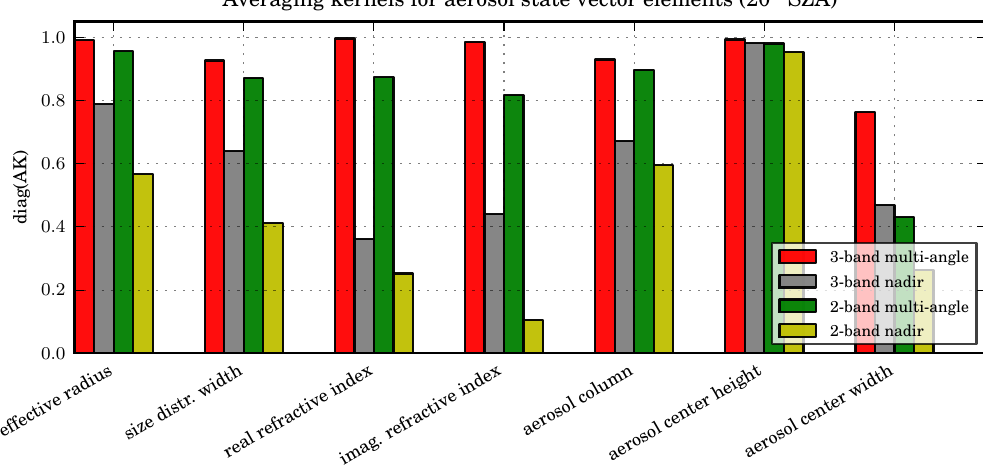
Fig. 5. Averaging kernel diagonal elements related to aerosols in the small solar zenith angle case ( ≈ 20 ◦ ). FWHM=0.04nm, 0.075nm and 0.1nm in the O 2 A-band, weak CO 2 /CH 4 band and strong CO 2 band, respectively; 2.5 spectral samples per FWHM, SNR=200 for each band.